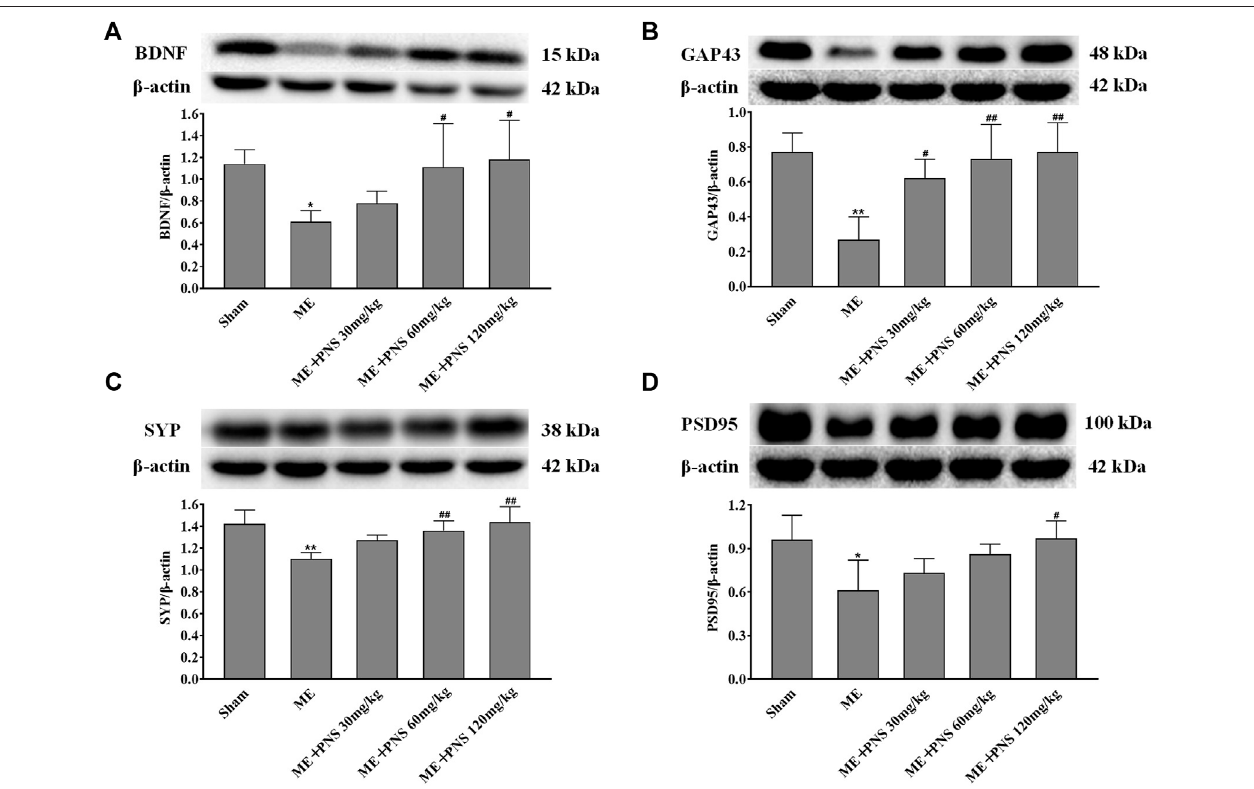
FIGURE 6 | PNS administration enhanced synaptic plasticity by increasing the expressions of BDNF and synaptic formation-related proteins GAP43, SYP, and PSD95 in hippocampus of ME Rats. The expressions of BDNF (A) , GAP43 (B) , SYP (C) , and PSD95 (D) in hippocampus tissues were assessed by Western blot. Data were presented as means ± standard deviation ( n = 3 animals per group). * p < 0.05, ** p < 0.01 versus Sham group; # p < 0.05, ## p < 0.01 versus ME